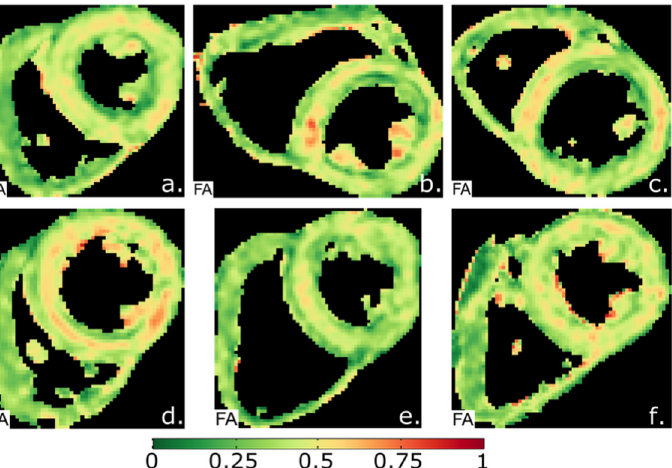
Fig 4. Typical examples of fractional anisotropy (FA) maps. The maps show a circumferential increase in FA (red) in the mesocardium, indicating a more anisotropic composition of myocytes compared to the endo- and epicardium.